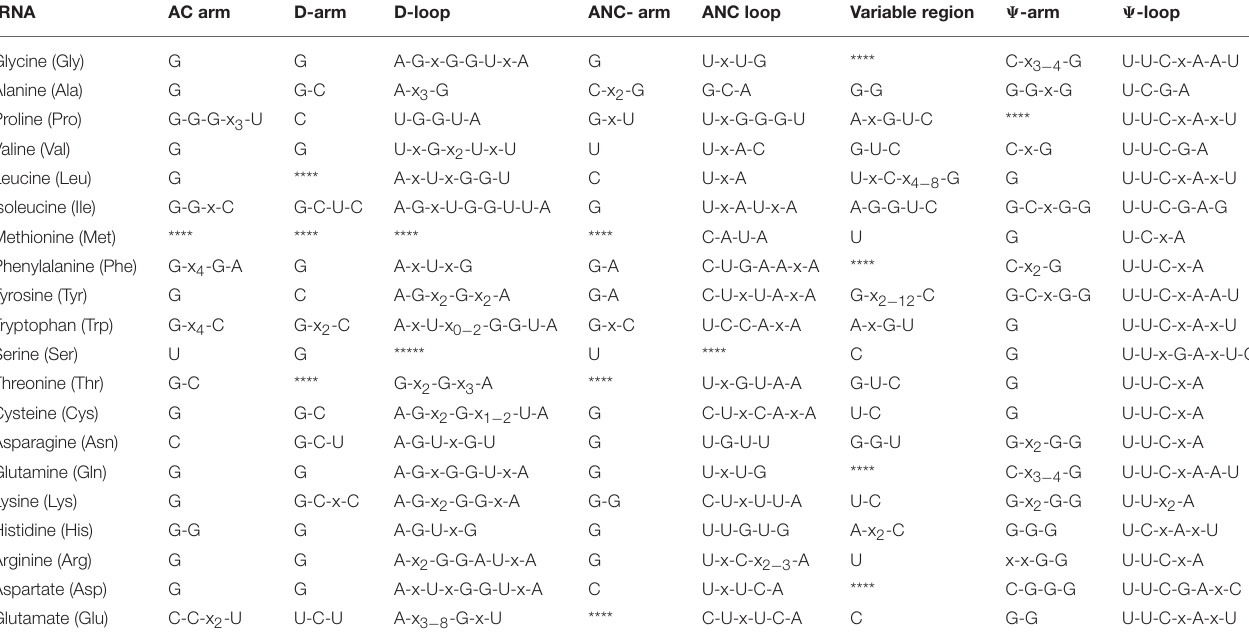
TABLE 5 | Conserved nucleotides of O. sativa